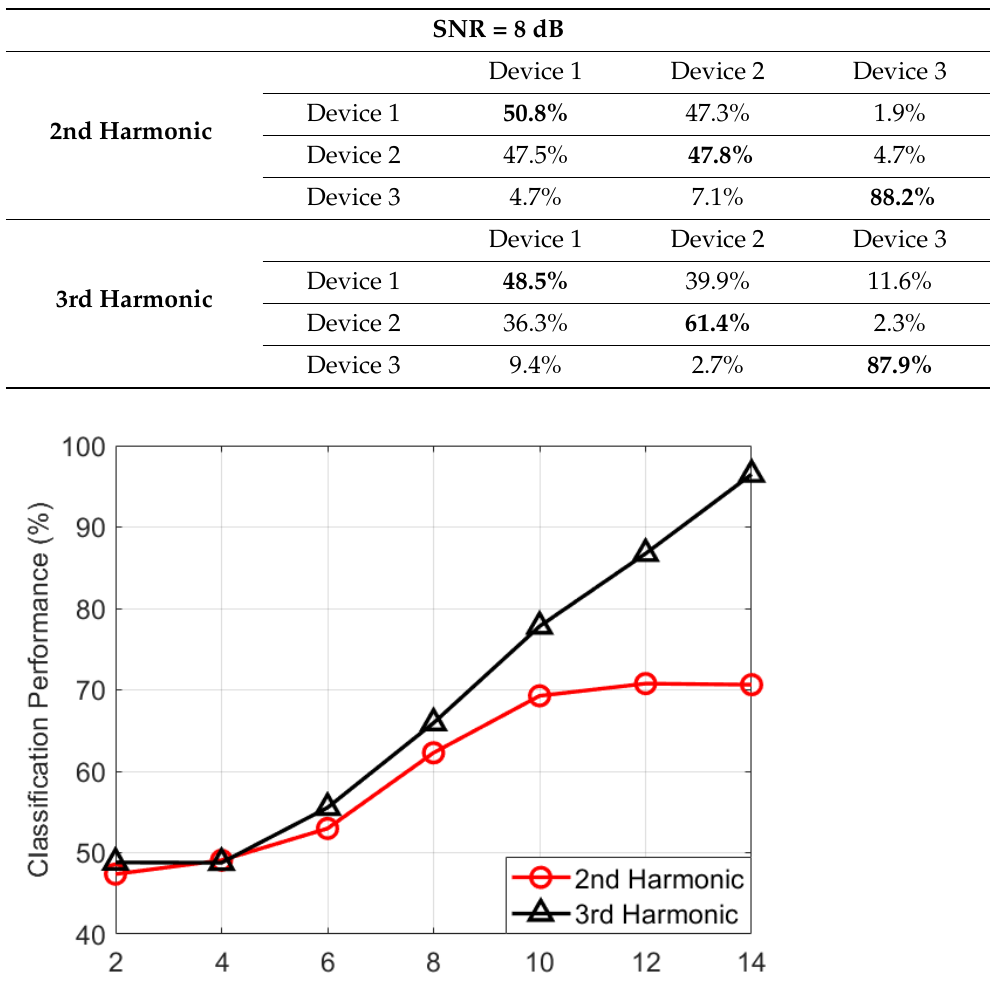
Table 5. Confusion matrices for the harmonics in the Fourier feature space for SNR = 8 dB.